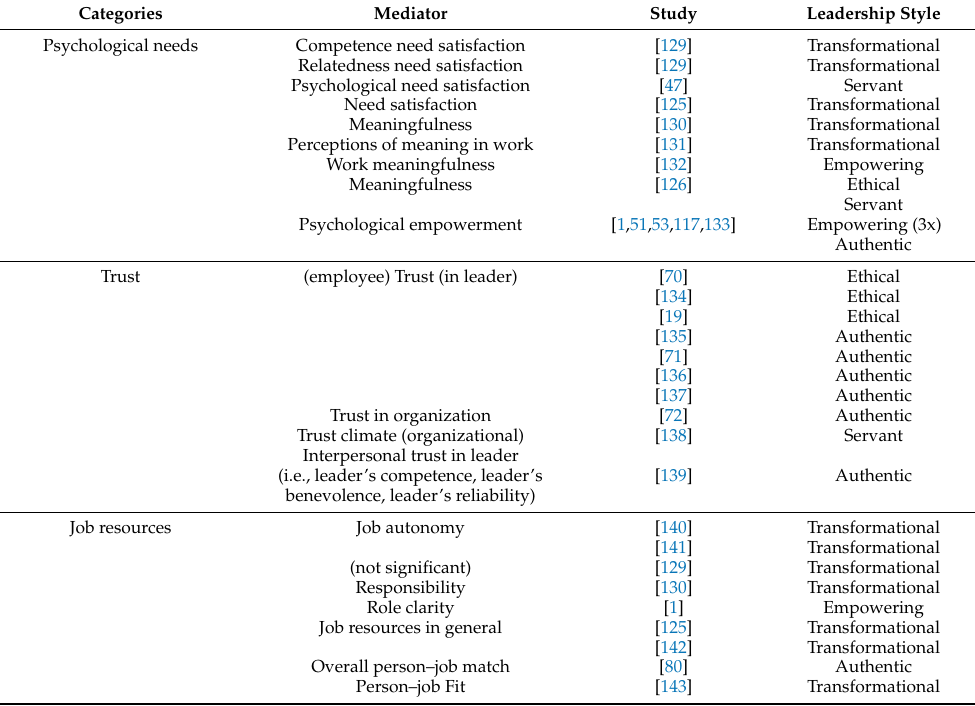
Table 5. Mediators in the leadership–engagement relationship from articles in the